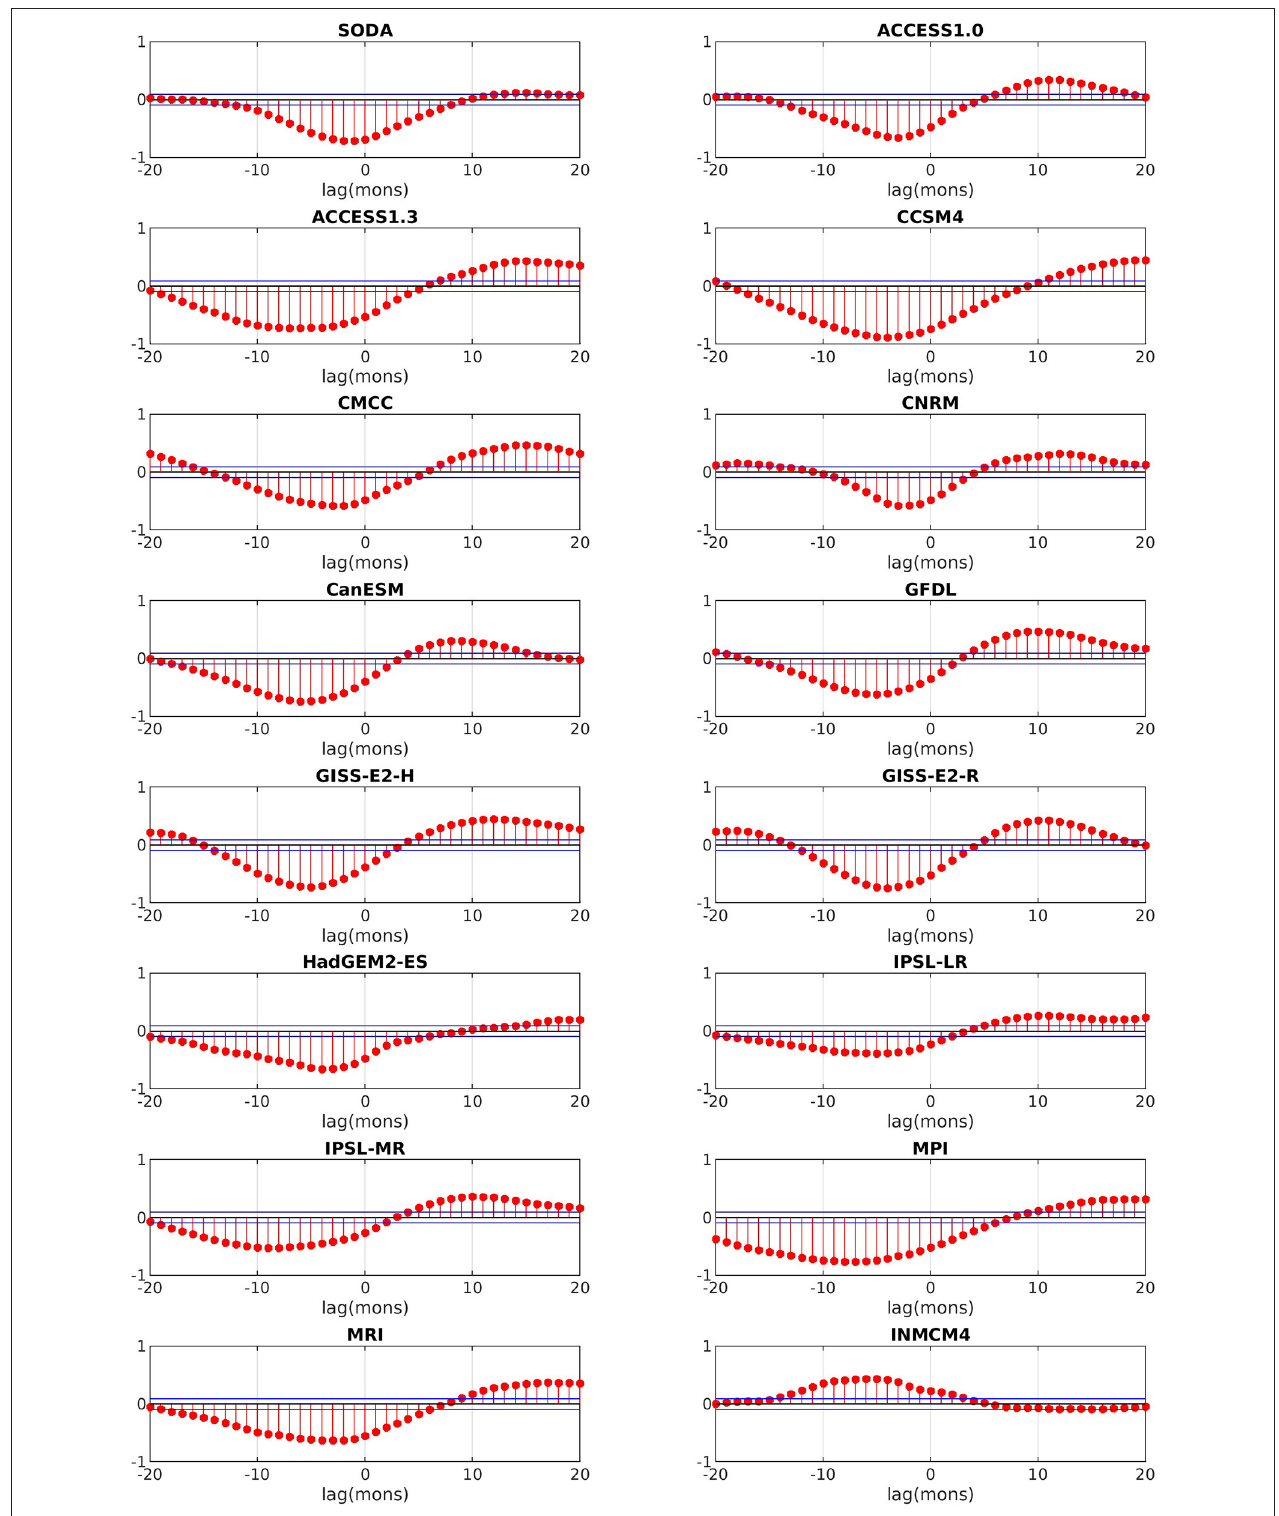
FIGURE 10 | Cross correlation between the Indonesian Throughflow (ITF) thermocline depth anomaly and the Niño3.4 index during 1967–2005 for models and during 1980–2018 for SODA reanalysis. Positive (negative) lags indicate ITF lags (leads) the Niño3.4 index.